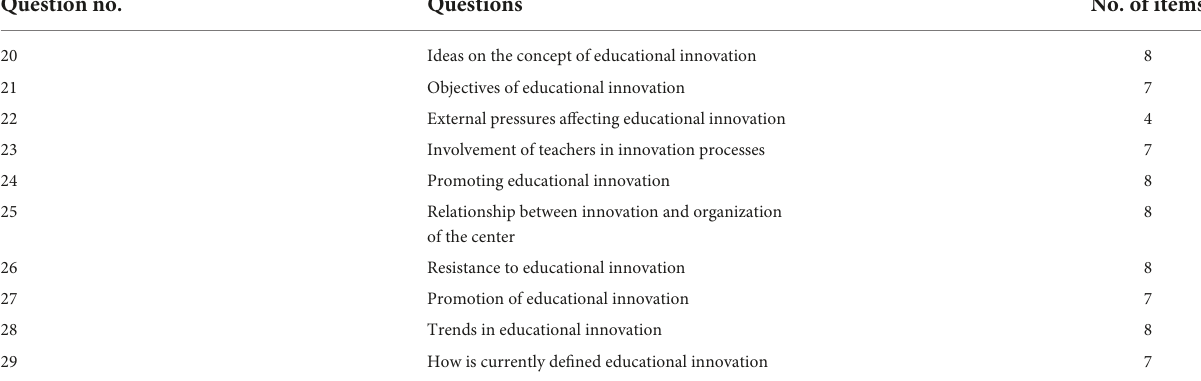
TABLE 3 Selection of questions from educational innovation and innovation culture, topic (c) of the second phase, Questionnaire 2. Question